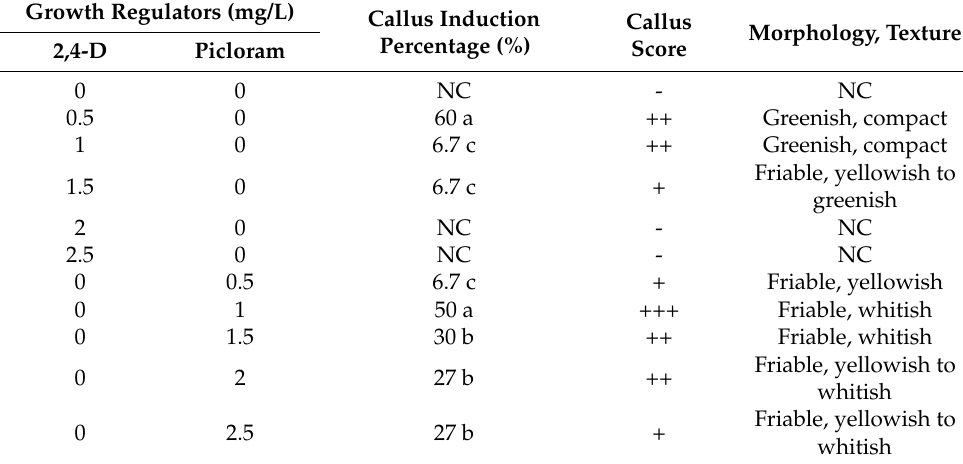
Table 2. The effects of 2,4-D and picloram at different concentrations on the callus induction percent- age of leaf explants of Labisia pumila var. alata after 4 weeks of culture. Growth Regulators (mg/L)